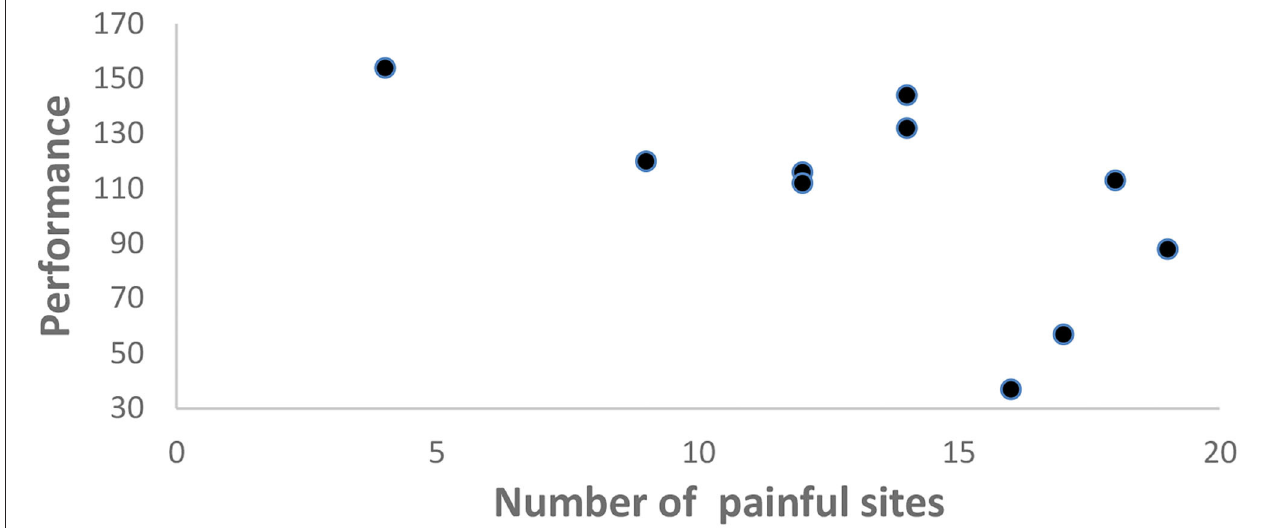
FIGURE 3 | Scatter plot showing the significant negative correlation between WPI score (number of pain sites) and task performance i.e., number of repetitions achieved at the end of the experiment ( p = 0.049; r = − 0.634).